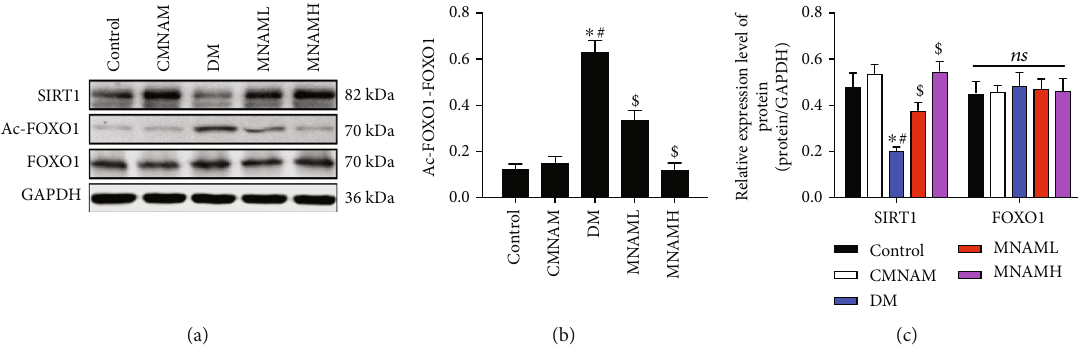
Figure 6: MNAM activates Sirt1 expression and inhibits acetylation of FOXO1 in the liver of obese T2DM mice ( n = 3 ). (a) Western blots; (b) bar graphs of acetylation of FOXO1; (c) bar graphs of SIRT1 and FOXO1. ∗ Compared with the control group, P < 0 : 05 ; # compared with the CMNAM group, P < 0 : 05 ; $ compared with the DM group, P < 0 : 05 ; ns: not signi fi cant, P > 0 : 05